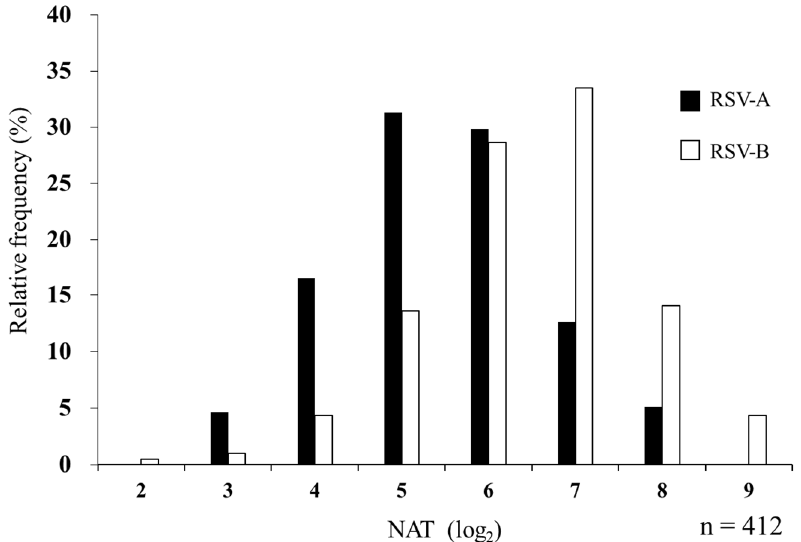
Figure 3. Relative frequency histogram of serum NAT against RSV-A and RSV-B in maternal blood. In total, 412 MB samples were evaluated for NATs against RSV-A and RSV-B. The maximum dilution of serum that suppressed the appearance of viral CPE by 50% is represented by log 2 as NAT. Black and white bars indicate NATs against RSV-A and RSV-B, respectively.